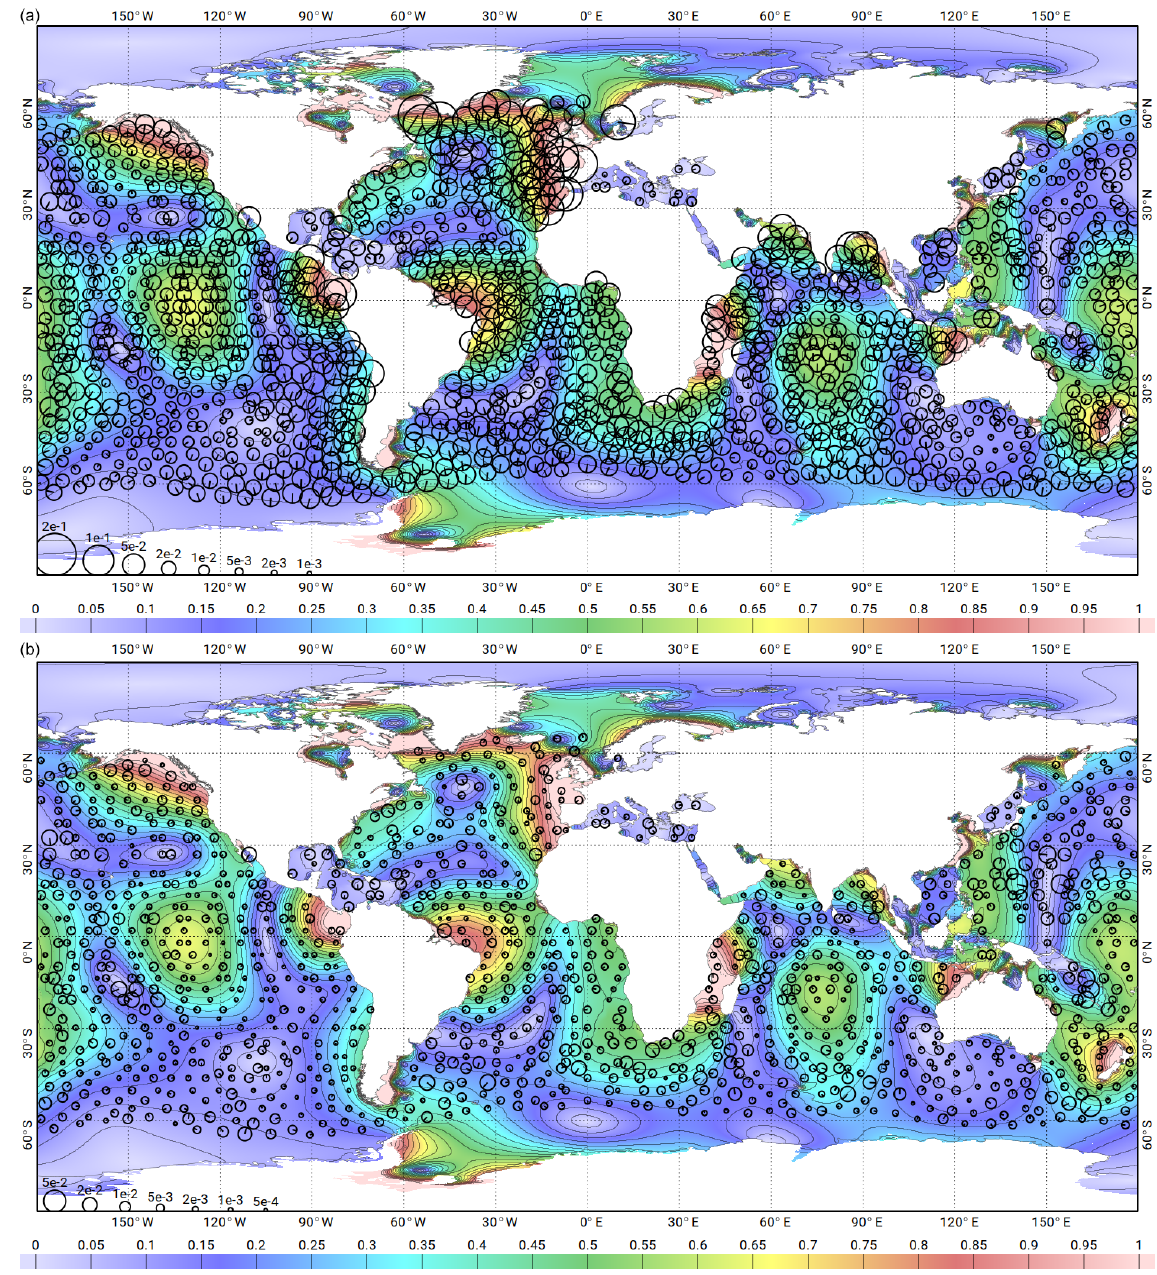
Figure 2. Vector differences (black circles) between the purely hydrodynamic solutions of FES2012 (a) and FES2014 (b) , and the deep TP/J1/J2 altimeter crossover points, for the M2 tidal component. The accuracy improvement between the FES2012 and FES2014 prior solutions is a key ingredient in the accuracy improvement between the FES2012 and FES2014a/b/c assimilated solutions. The size of the black circles is proportional to the square root of the amplitude of the vector difference between the solutions and the observations (see bottom left normalized symbols; units are in metres). The line inside circles shows the vector difference phase. The background colour shows the amplitude of the M2 tidal component from the model (in